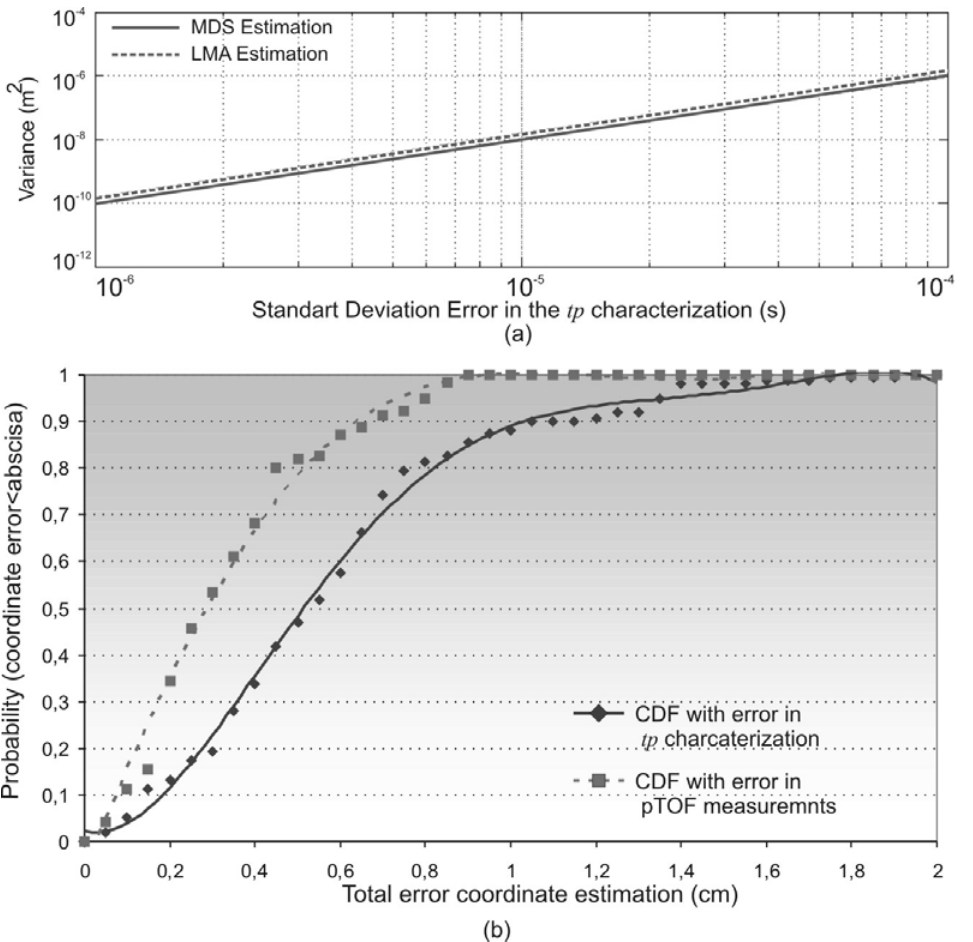
Figure 7. Position estimation with errors in tp characterization. (a) Total variance in the coordinate estimation of eight nodes. (b) CDF in the position estimation of node N